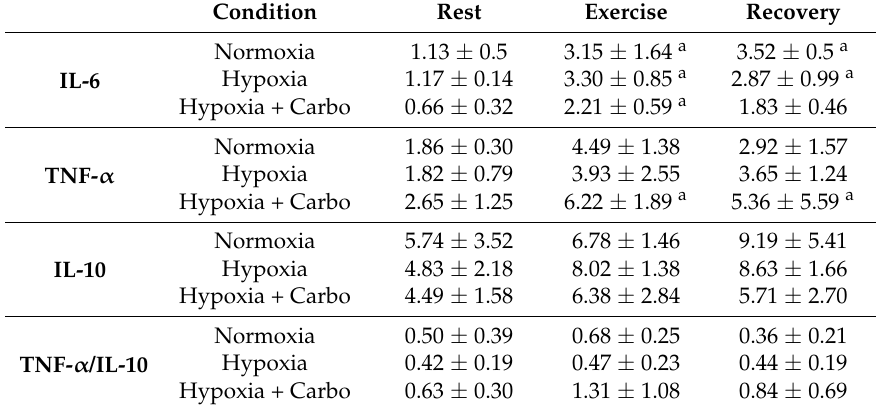
Table 3. Serum concentration of IL-6, TNF- α and IL-10 and TNF- α /IL-10 at rest, after exercise and after recovery in normoxia, hypoxia and hypoxia +